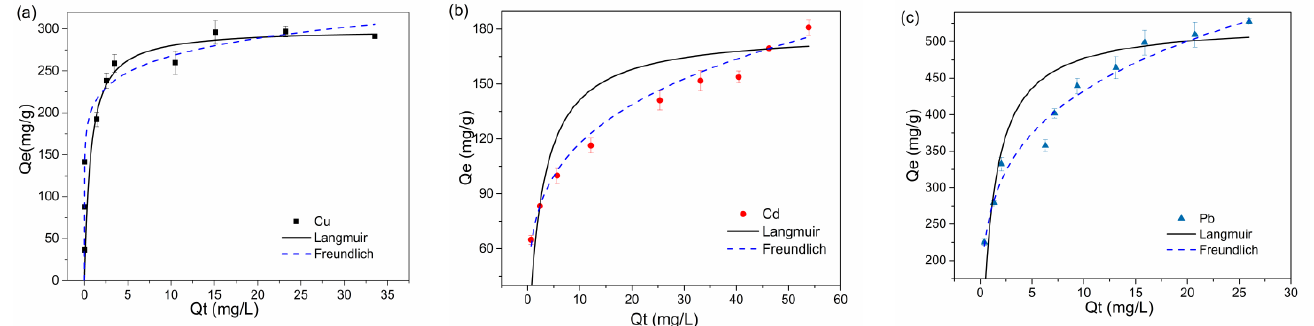
Figure 5. Sorption isotherms of Cu(II) ( a ), Cd(II) ( b ), and Pb(II) ( c ) sorption by 15%Mg-BC. Table 3. Sorption isotherms parameters of Cu(II), Cd(II), and Pb(II) sorptions by biochar.